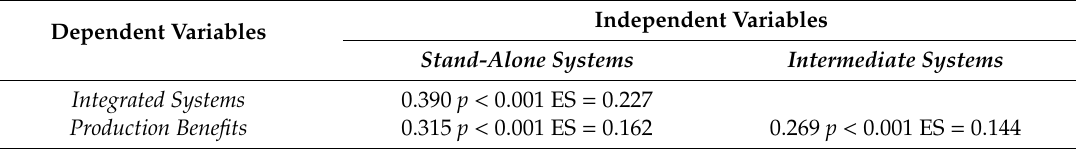
Table 9. Total indirect e ff